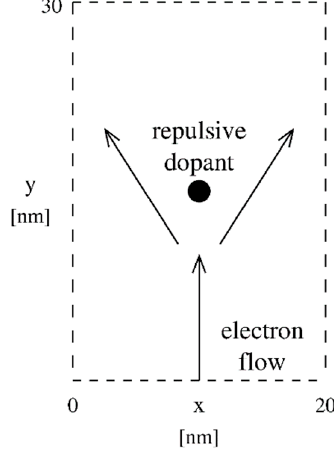
Figure 1. The two-slit electron problem: simulation setup.